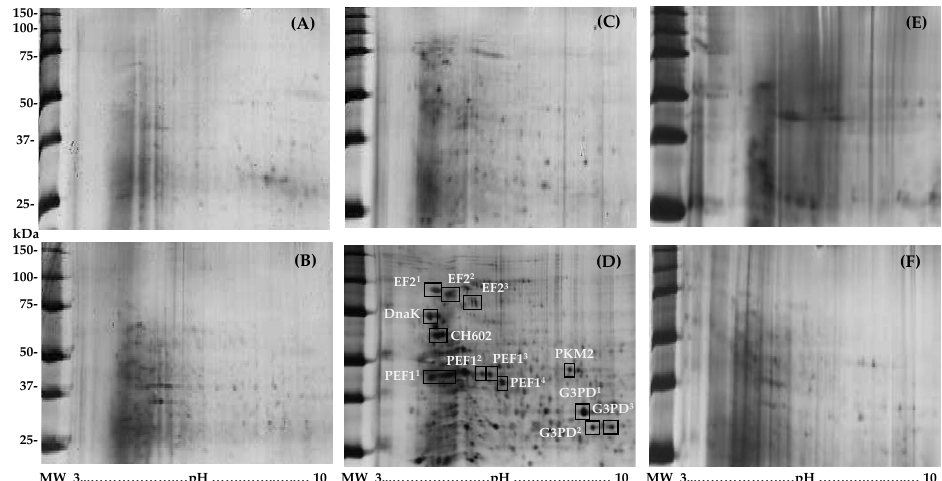
Figure 2. Representative 2-DE protein maps obtained from each pool of TSCM samples. ( A ) C group in the basal condition; ( B ) C group 4 weeks post-surgery; ( C ) CHX group in the basal condition; ( D ) CHX group 4 weeks post-surgery and with mouthwash rinsing; ( E ) CHX+ADS group in the basal condition; ( F ) CHX+ADS 4 weeks post-surgery and with mouthwash treatment. Abbreviated protein names correspond with those reported in Table 3. Bi-dimensional separation was carried out by an IPG strip, pH range 3–10 (first-dimension) and gradient gel 8–16% (second-dimension). The molecular weight marker is expressed in a kilodalton